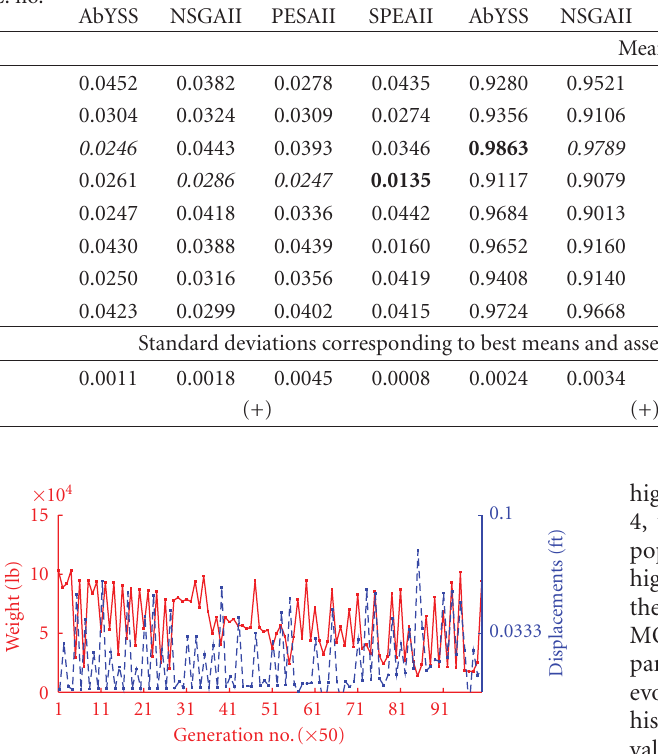
Table 3: Values of measurement quantities obtained by “Eval. Number = 5,000” and “Pop. Size = 100” for design example 1. C. no.